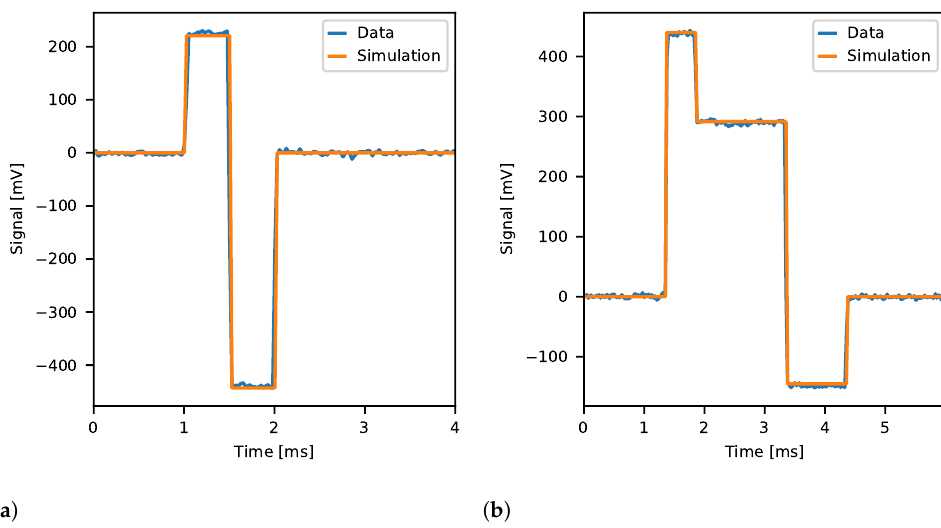
Figure 16. Current pulse stimulation waveforms of ( a ) diphase and ( b ) triphase pulses with their software simulation based on the real-time Output Bitstream analysis. The channel baseline level was subtracted from the data for better visibility and direct comparison.